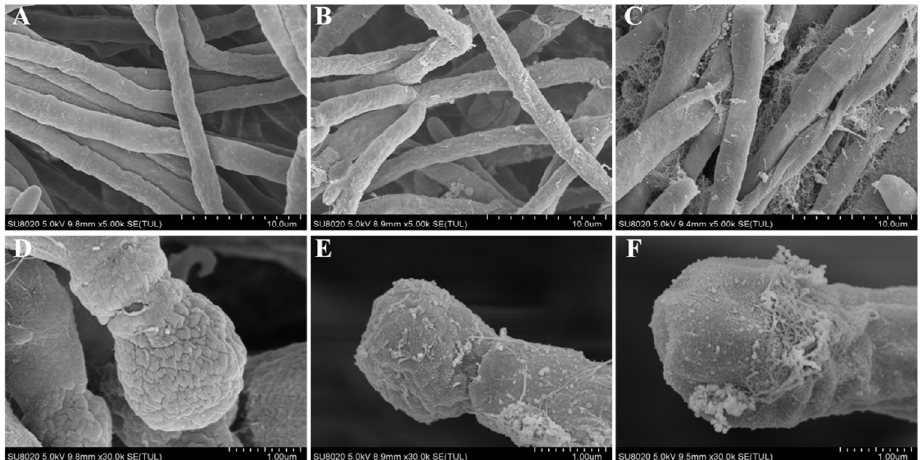
Figure 4. Morphology of the mycelia ( A – C ) and conidia ( D – F ) of P. italicum, as observed by scan- ning electron microscopy (SEM), after treatment with water ( A , D ), 160 μ g/mL EG nanoemulsion electron microscopy (SEM), after treatment with water ( A , D ), 160 µ g/mL EG nanoemulsion ( B , E ), ( B , E ), and 160 μ g/mL EGL nanoemulsion ( C , F ). Scale bar, 10 μ m for mycelia and 1 μ m for spore. and 160 µ g/mL EGL nanoemulsion ( C , F ). Scale bar, 10 µ m for mycelia and 1 µ m for